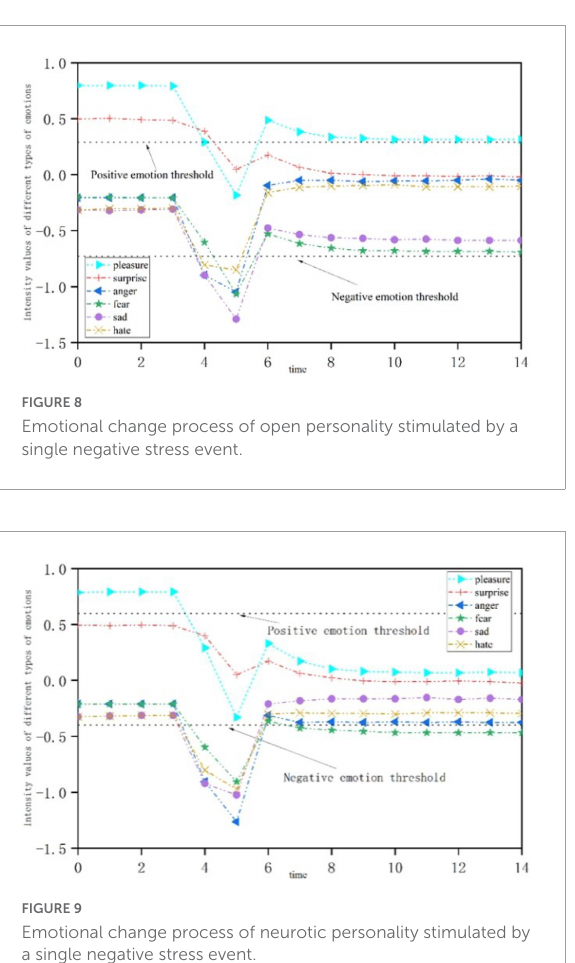
FIGURE7 Emotional change process of neurotic personality stimulated by a single positive stress event.